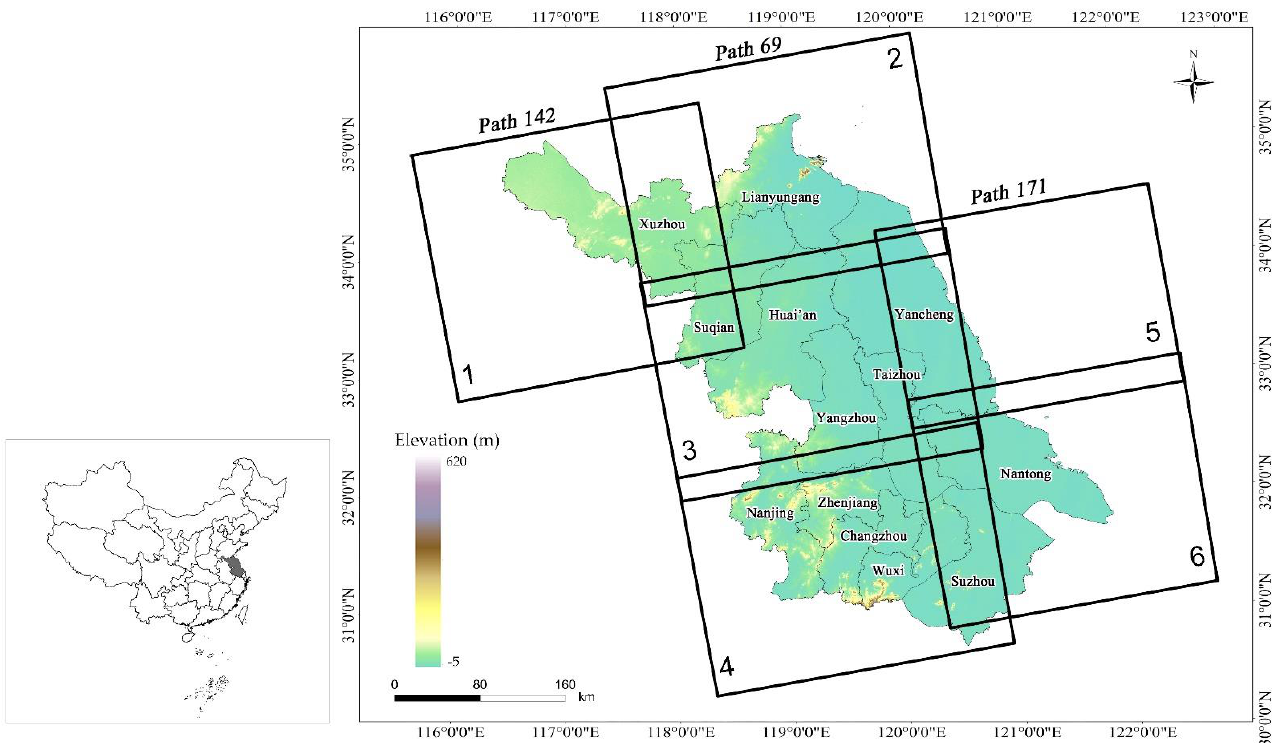
Figure 1. S-1 frame coverage over the whole Jiangsu province. The background is the Shuttle Radar Topography Mission (SRTM) digital elevation model (DEM) with elevation tuned by color. The location of Jiangsu province in China is shown in grey in the thumbnail image in the left. Table 1. Composition of S-1 image stacks. Frame